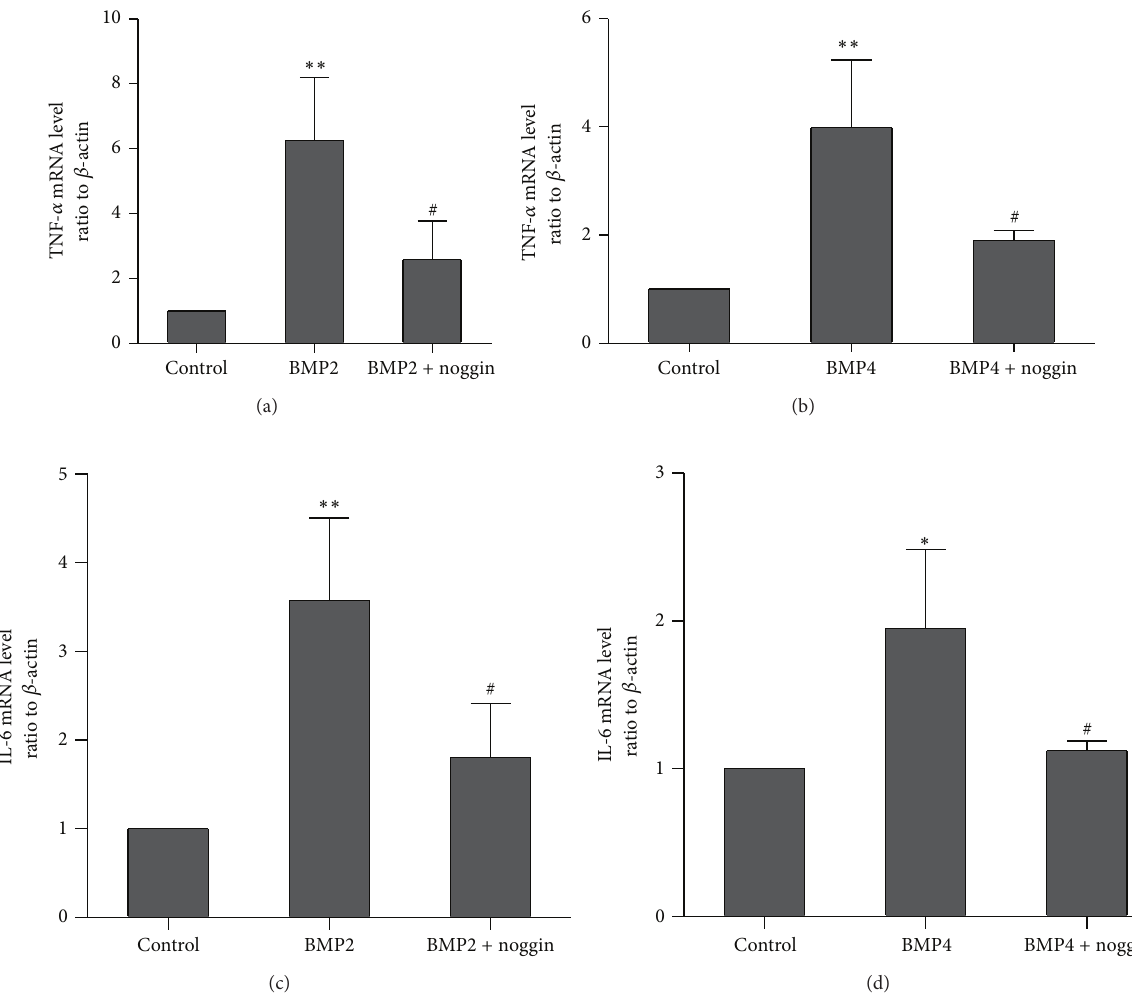
Figure 4: (a) BMP2 (100ng/mL) significantly induced the expression of TNF- 𝛼 mRNA. BMP2 combined with noggin partially reversed the increase in the TNF- 𝛼 mRNA. (b) The effect of BMP4 in inducing the expression of TNF- 𝛼 mRNA was weaker compared to BMP2, and the expression of TNF- 𝛼 mRNA induced by BMP4 was also decreased by noggin. (c) and (d) BMP4 and BMP2 both increased the expression of IL-6 mRNA, and these effects were decreased by noggin. ∗ Different from the control after BMP2 and BMP4 treatment, ∗∗ 𝑃 < 0.01 , ∗ 𝑃 < 0.05 . # Different from a single treatment with BMP2 or BMP4, 𝑃 < 0.05 . Data are representative of 3 similar experiments.